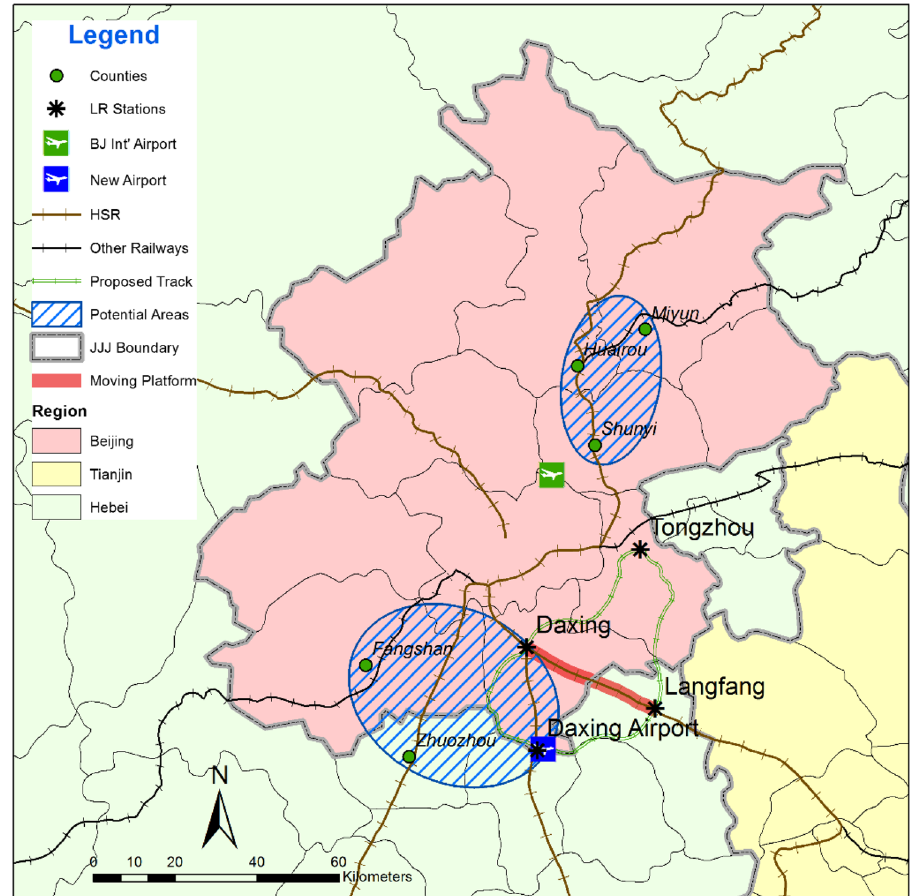
Fig. 4 Other potential